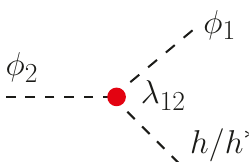
Figure 8 . Decay of (cid:30) 2 through the (cid:21) 12 interaction. The emitted Higgs can be on- or o(cid:11)-shell depending on the mass di(cid:11)erence of (cid:30) 2 and (cid:30) 1